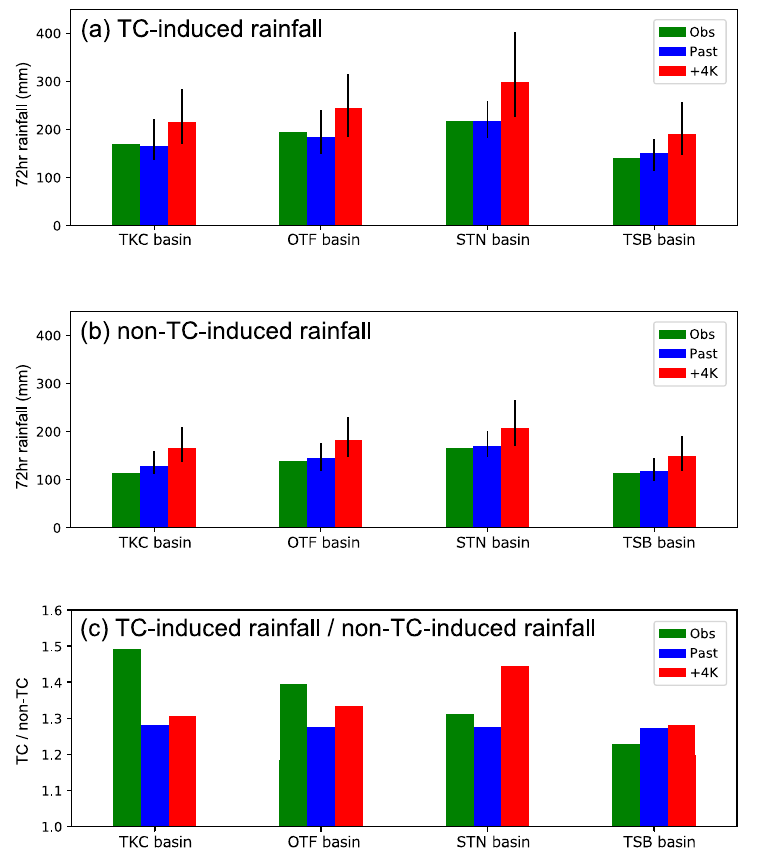
Figure 2. The 90th percentile of annual maximum 72 h rainfall volume of ( a ) TC-induced rainfall events and ( b ) non-TC-induced rainfall events. The bars indicate median values and error bars show the 5th–95th percentile of ensemble members. ( c ) The ratios between median value of TC-induced and non-TC-induced rainfall volume (TC/non-TC).